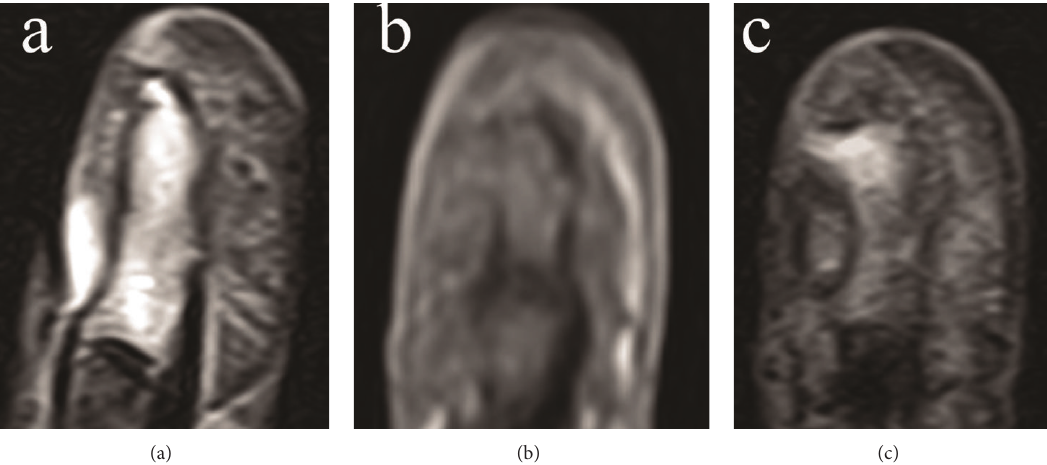
Figure 2: Sagittal view of short time inversion recovery magnetic resonance images (MRI) (a) and coronal views of T1 weighted (b) and T2 weighted (c) MRI.